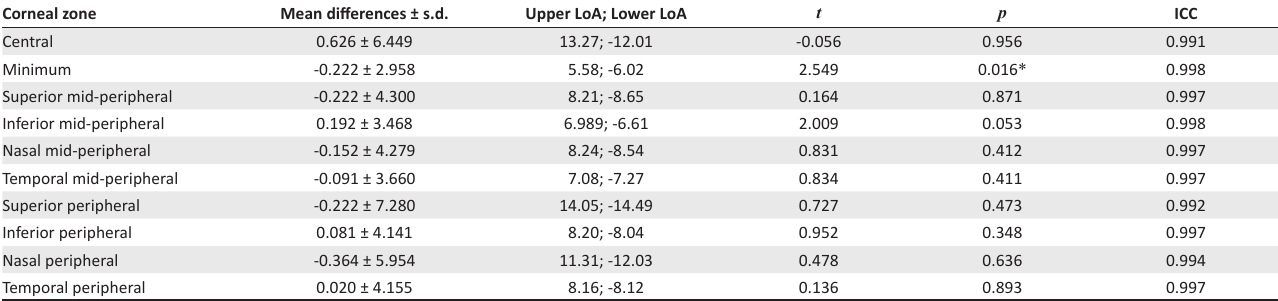
TABLE 3: The mean differences and standard deviations of corneal thicknesses ( µ m) for observer one taken over two sessions, Bland and Altman upper and lower limits of agreement, and t -value and p -value from linear regression and the intraclass correlation coefficient. Corneal zone Mean differences ± s.d. Upper LoA; Lower